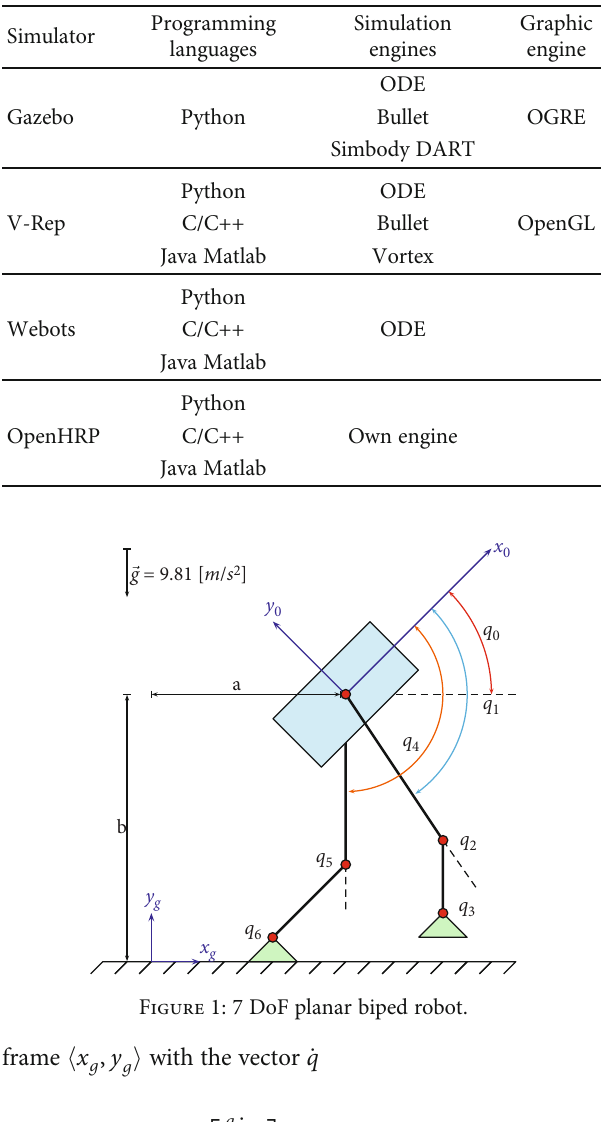
Table 1: Features of the most popular robotics simulators.